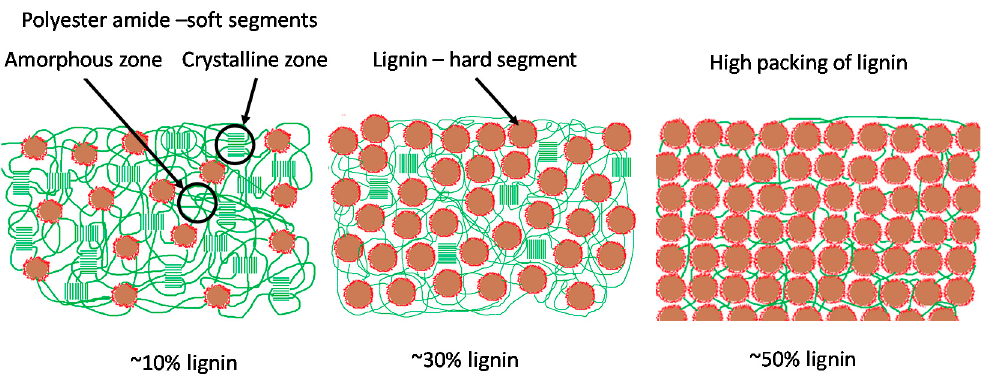
Figure 11. Schematic representation of the structure and packing of the lignin-copolyester/amides at 10, 30 and 50% lignin content.